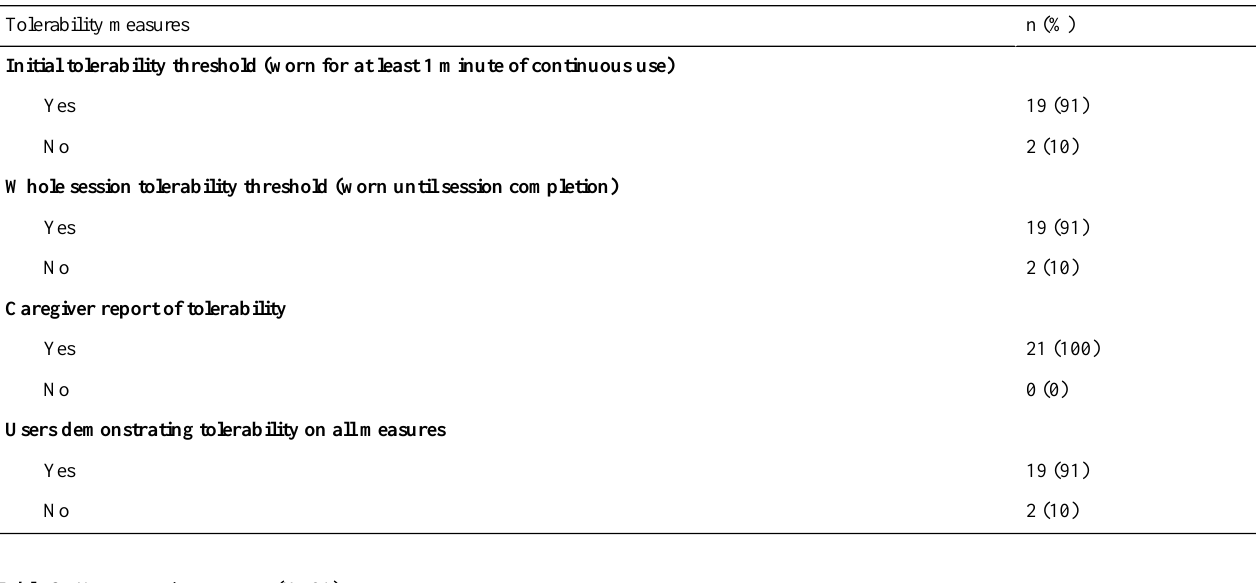
Table 2. Tolerability report of Brain Power Autism System (N=21).